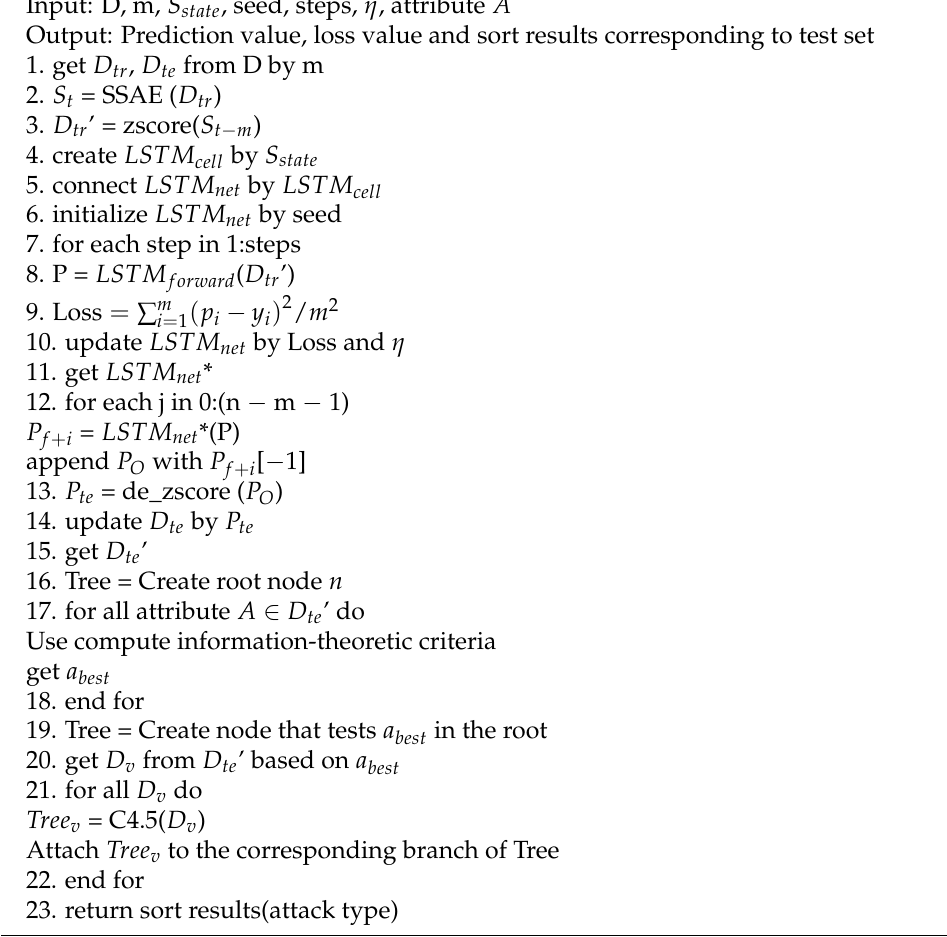
Algorithm 1 Network security situation awareness algorithm based on LSTM-DT